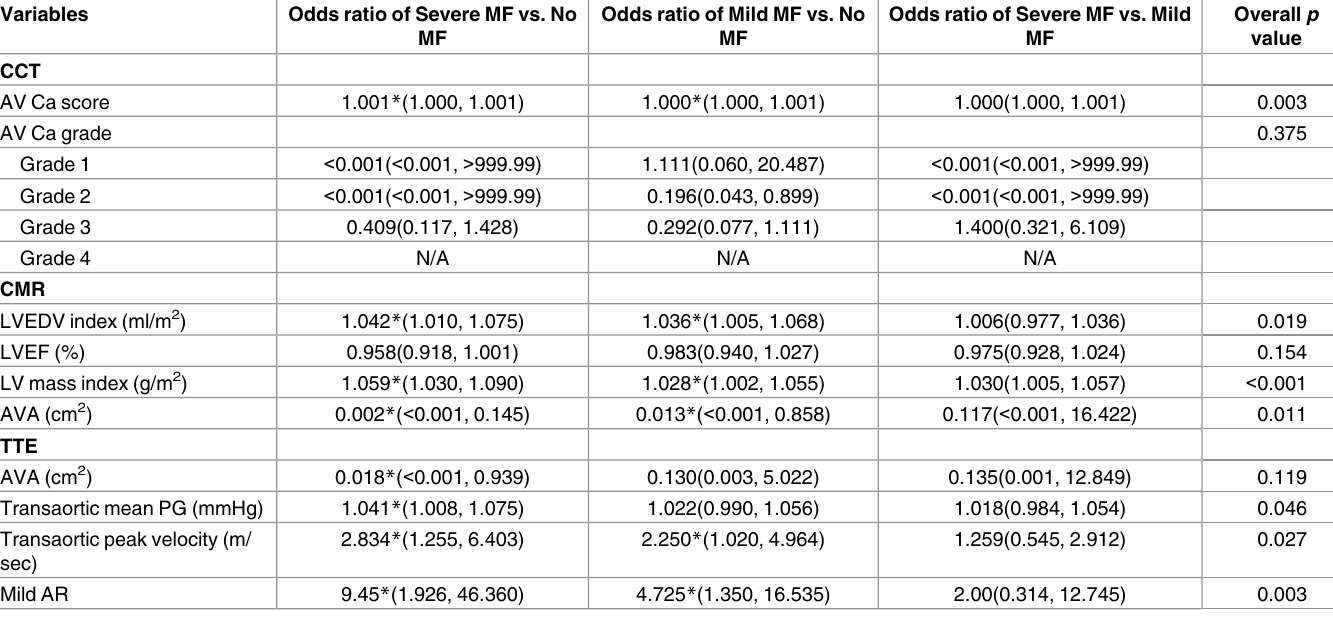
Table 3. Odds ratio for imaging variables for the severityof myocardial fibrosis on univariate multinomial logistic regression analysis.